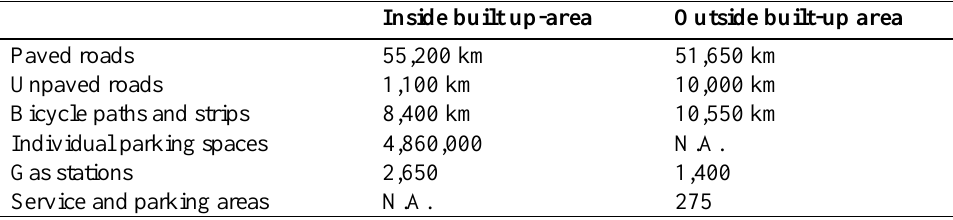
Table 2. Estimations of road infrastructure in the Netherlands (length, number), 1998 Inside built up-area Outside built-up area Paved roads 55,200 km 51,650 km 1,100 km 10,000 km Bicycle paths and strips